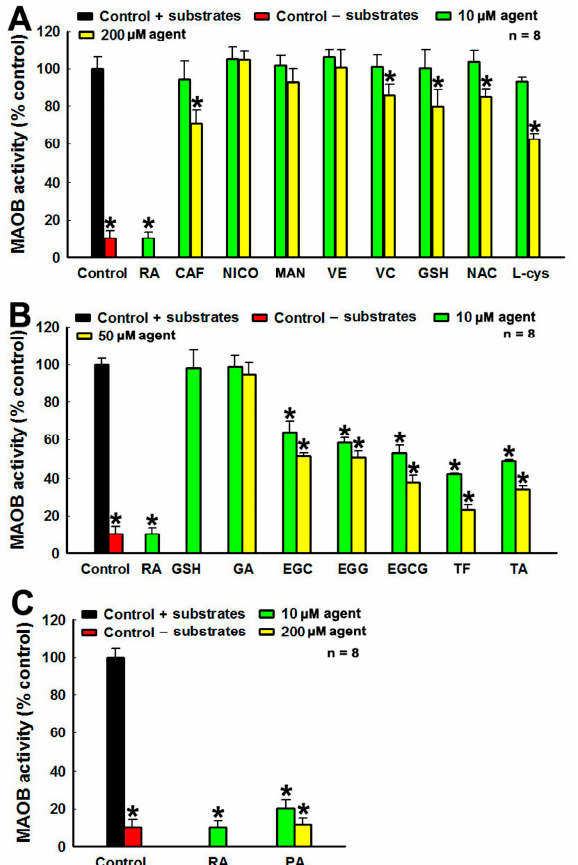
Figure 3. Inhibitions of monoamine oxidase B (MAOB) activity by tea polyphenols and other agents. MAOB activities of human dopaminergic SH-SY5Y cell lysates in the presence of MAOB inhibitors and tea polyphenols as well as other agents are detected. MAOB activity of cell lysates in the absence of MAOB inhibitor and other agents is set as controls. MAOB activity of cell lysates in the presence of MABO inhibitors or other agents is expressed as % control. *, at least p < 0.05, compared with MAOB activity of controls. ( A ) MAOB inhibition by 10 and 200 μ M caffeine (CAF), nicotine (NICO), mannitol (MAN), α -Tocopherol (VE), ascorbic acid (VC), GSH, NAC, and L-cys. ( B ) MAOB inhibition by 10 and 50 μ M tea polyphenols. ( C ) rasagiline (RA) and pargyline (PA) induced MAOB inhibition.